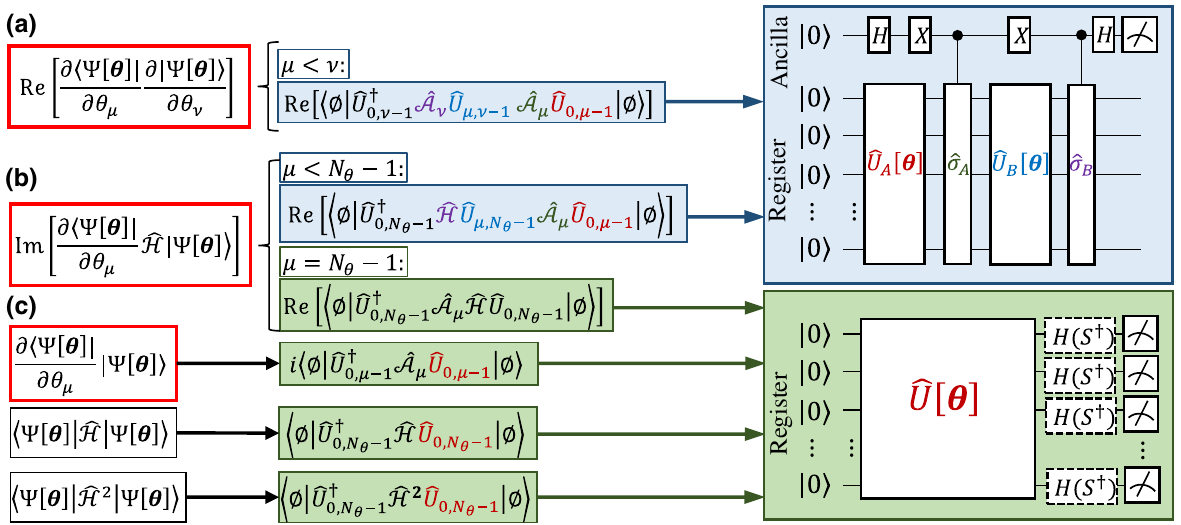
FIG. 2. Quantum-circuit implementation of the AVQDS algorithm. The left column lists the unique terms to be evaluated in Eqs. (5) and (7) of VQDS, with the terms (a)–(c) highlighted in red also involved in the ansatz adaptive procedure in AVQDS. The middle col- umn specifies the expressions when the wave-function ansatz takes the pseudo-Trotter form of Eq. (10) with ˆ U j , k [ θ ] = | 0 (cid:3) for an N -qubit system. Two types of quantum circuits are adopted: a green block for the direct mea- and | (cid:4) 0 (cid:3) = |∅(cid:3) ≡ ⊗ N − 1 j = 0 surement circuit, and a blue block for a generalized Hadamard test circuit [27,45]. The direct measurement circuit includes optional Hadamard gate H or Hadamard-phase gate HS † when measuring X or Y -Pauli strings present in ingly, ˆ U [ θ ] can be ˆ U 0, μ − 1 or ˆ U 0, N as highlighted in the middle column. In the generalized Hadamard test, the expectation value θ − 1